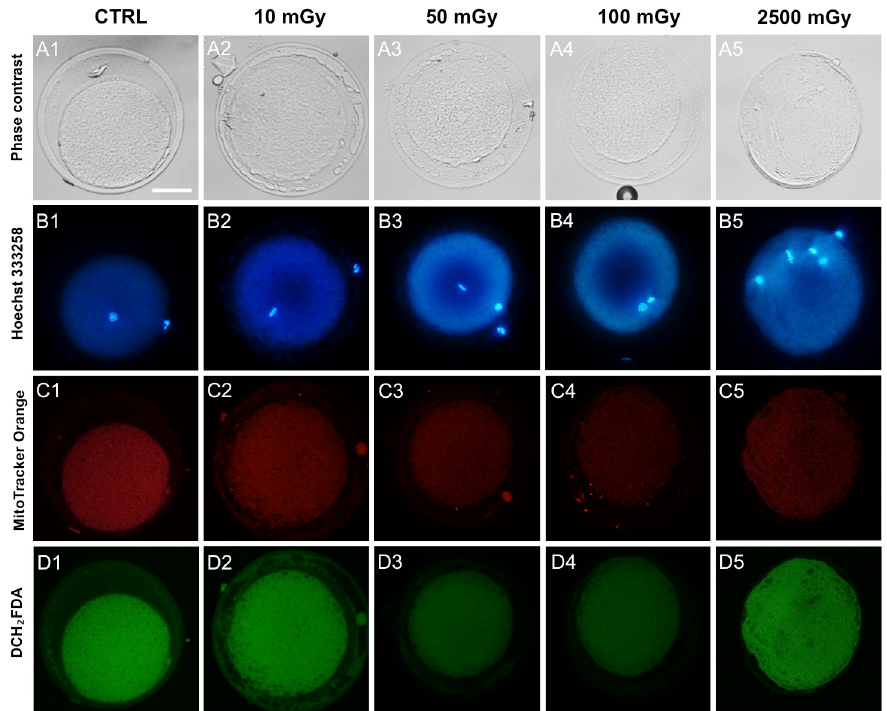
Fig 2. Representative micrographs of oocytes exposed to low-dose X-ray radiations and examined for their nuclear chromatin and bioenergetic/oxidative potential. Representative images of a control oocyte (column 1) and oocytes exposed to 10–2500 mGy (column 2–5) before IVM. Corresponding phase contrast images showing cell morphology (line A), epifluorescence images showing nuclear chromatin configuration (line B) and confocal images showing mitochondria (line C) and intracellular ROS (line D). Confocal images were taken at oocyte equatorial plane. Scale bar represents 40 μ m.